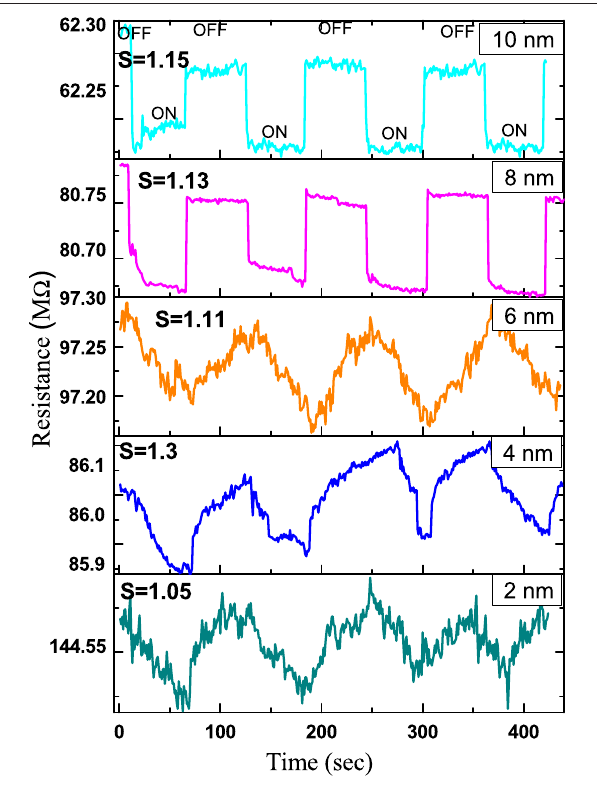
FIGURE 14 | UV-sensing of unannealed Au layer at various thicknesses with a cycle of 1 min. FIGURE 15 | UV-sensing of annealed Au layers at various thicknesses